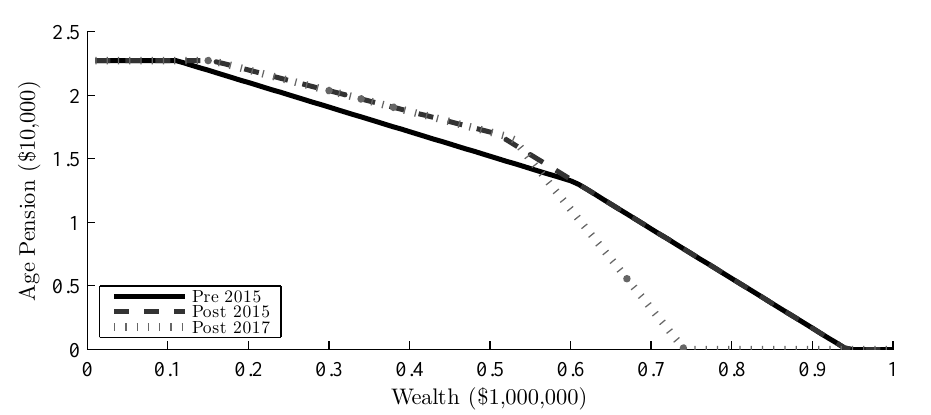
Figure 4. Comparison of the Age Pension function with the three policy scenarios, based on a single household aged 65–74 and where consumption is assumed to be the minimum withdrawal rate of